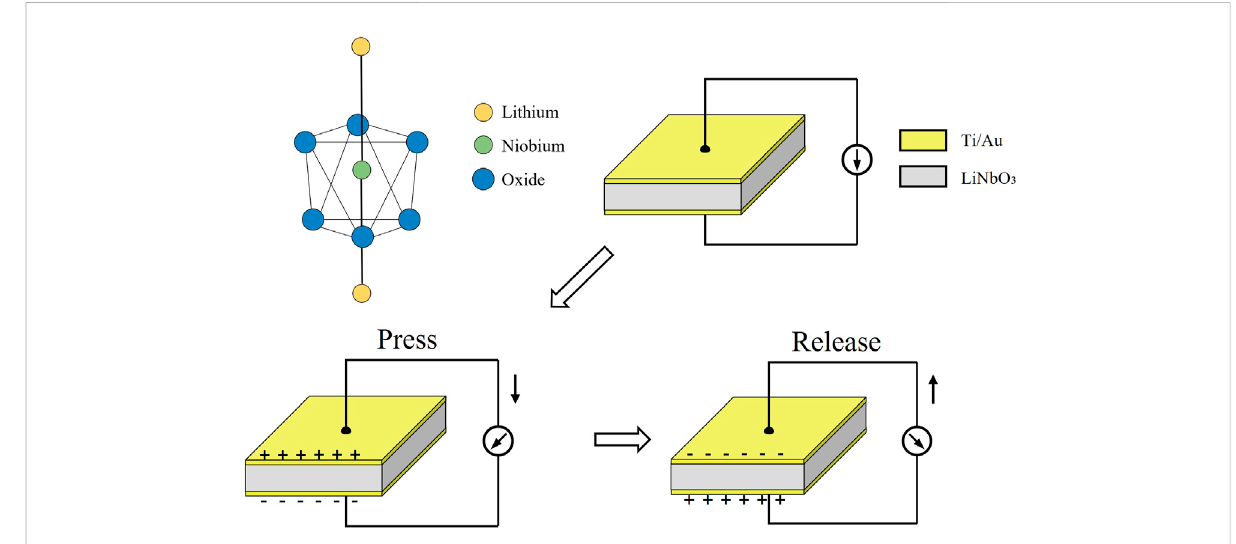
FIGURE 2 LiNbO 3 lattice structure and diagrams of internal and surface charges under pressure and